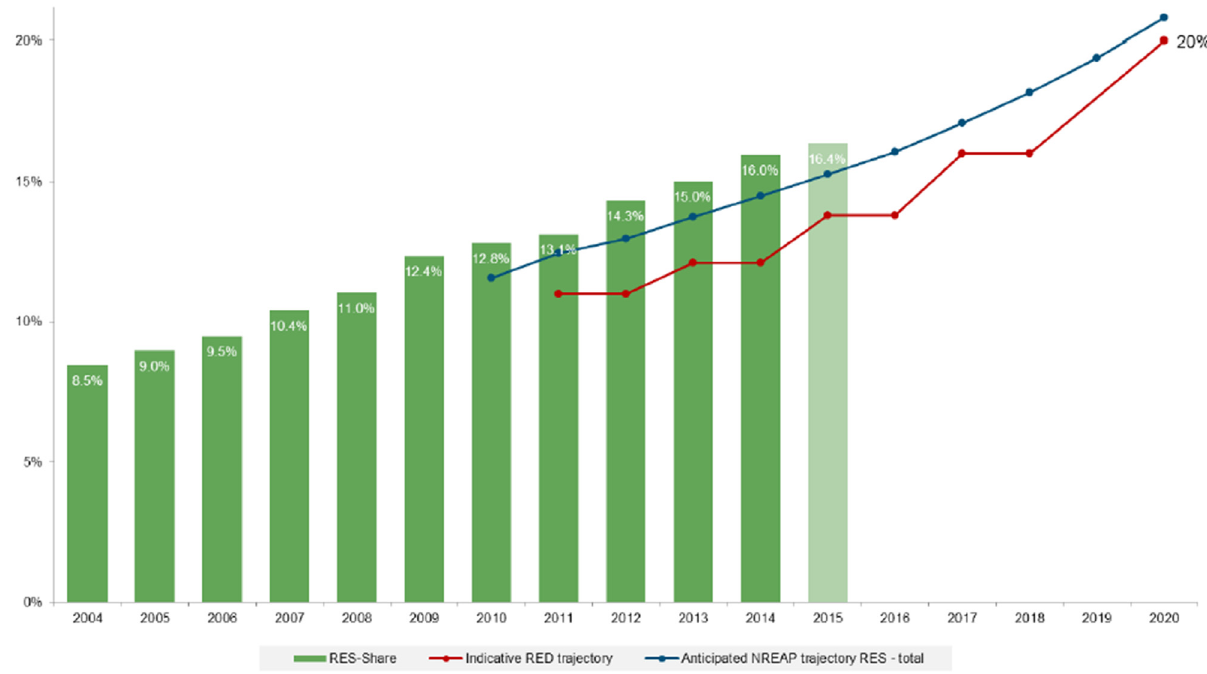
Fig. 1. Renewable energy shares in the EU versus Renewable Energy Directive (RED) and National Renewable Energy Action Plan (NREAP) trajectories (based on EUROSTAT, Öko-Institut). Source: COM 2017